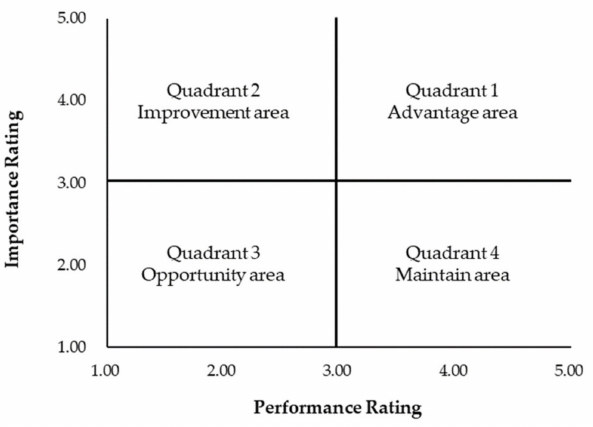
Figure 6. Importance-performance analysis (IPA) grid